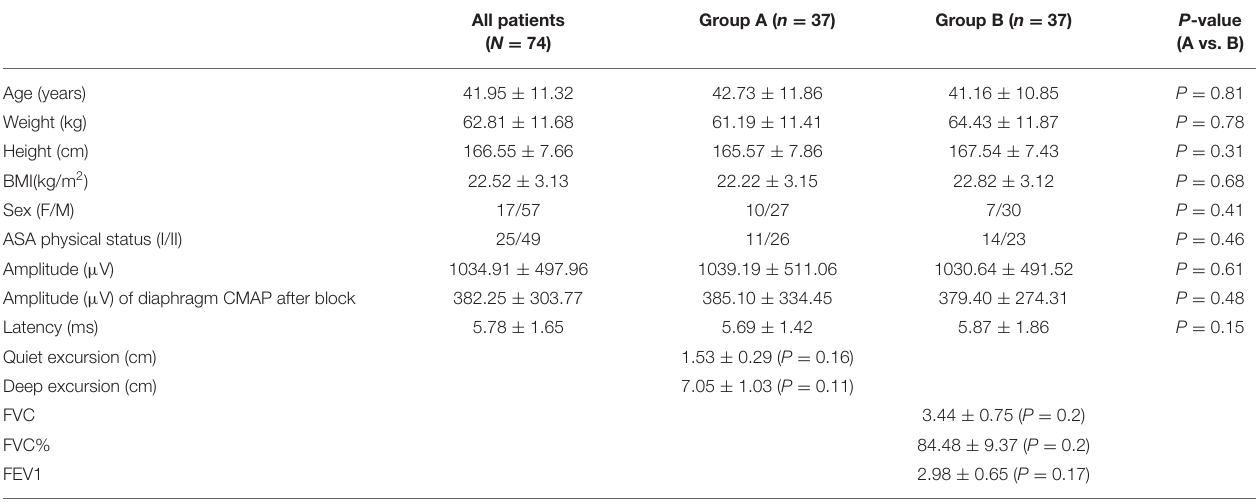
TABLE 1 | Baseline demographic and clinical characteristics of the study population.